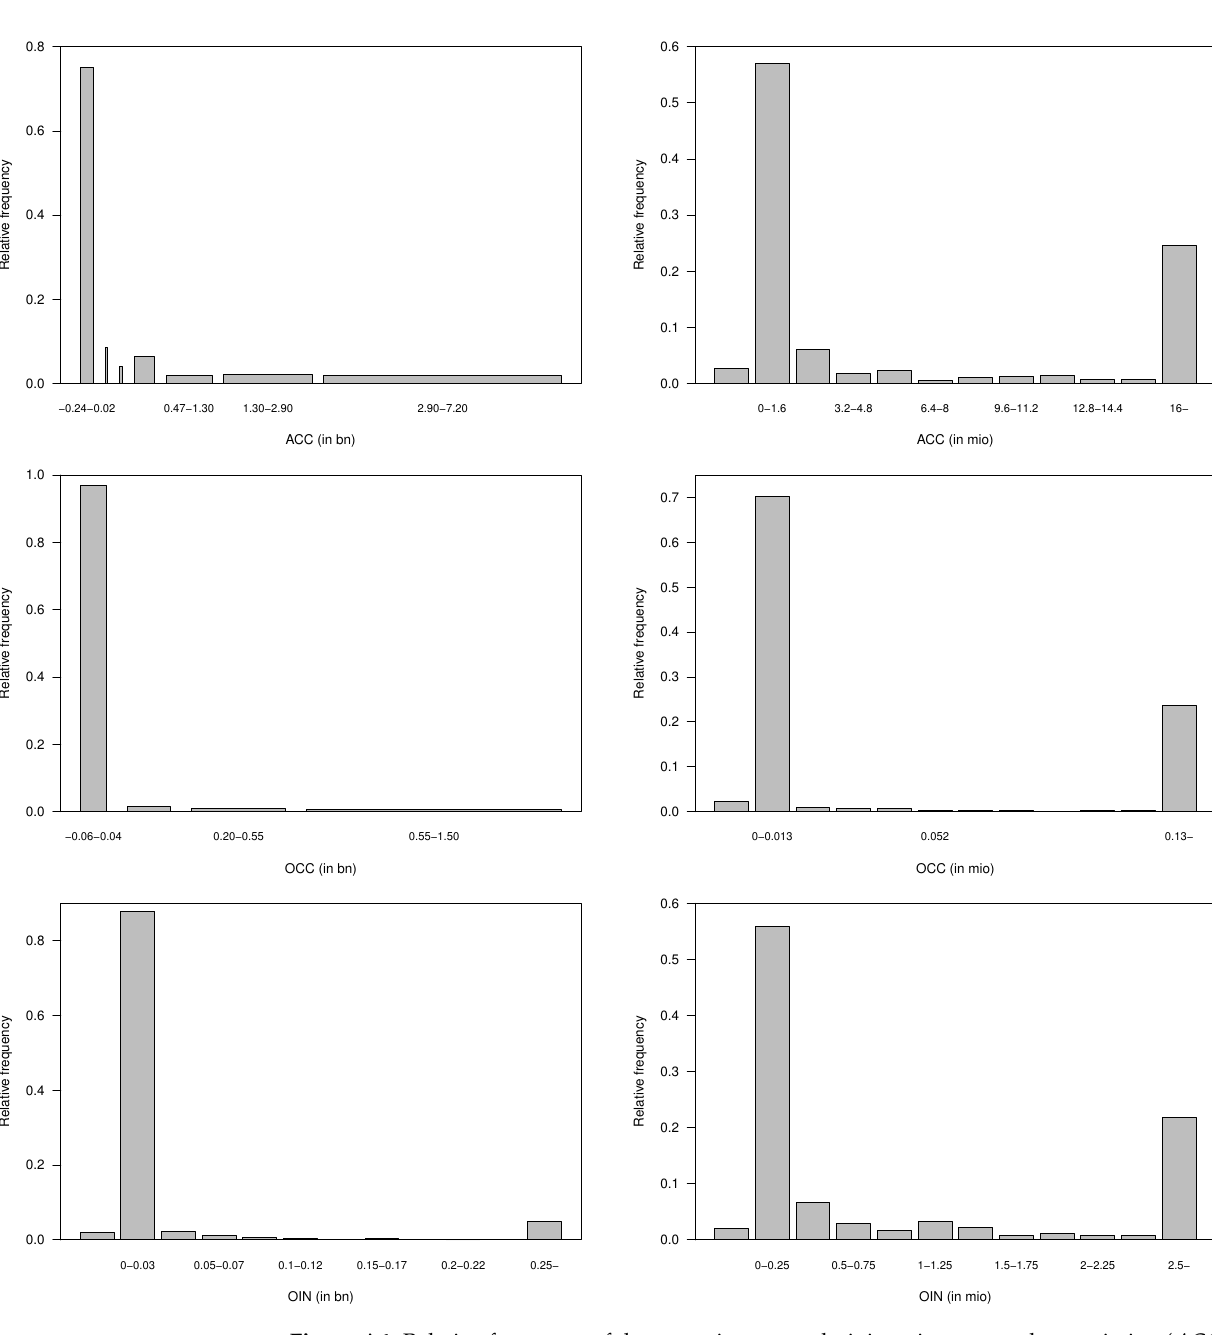
Figure A4. Relative frequency of the operation cost, administration cost and commission ( ACC ) and other costs ( OCC ), and of the other income ( OIN ) for reinsurance undertakings. The figure presents twice the relative frequency of ACC , OCC and OIN : ACC and OCC are once sliced by the optimal bin out of our model and once sliced by equal bands. OIN is once sliced by billion and once sliced by